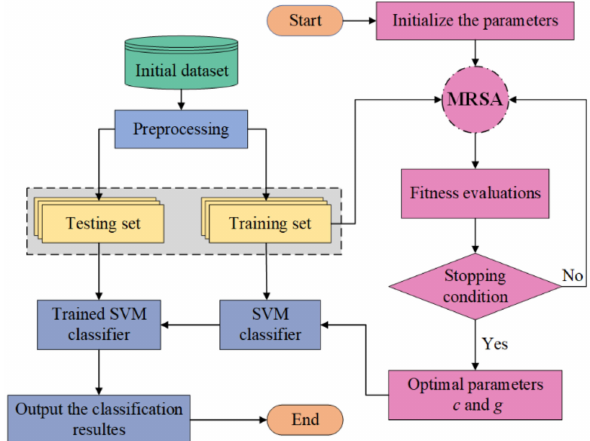
Figure 2. MRSA-SVM